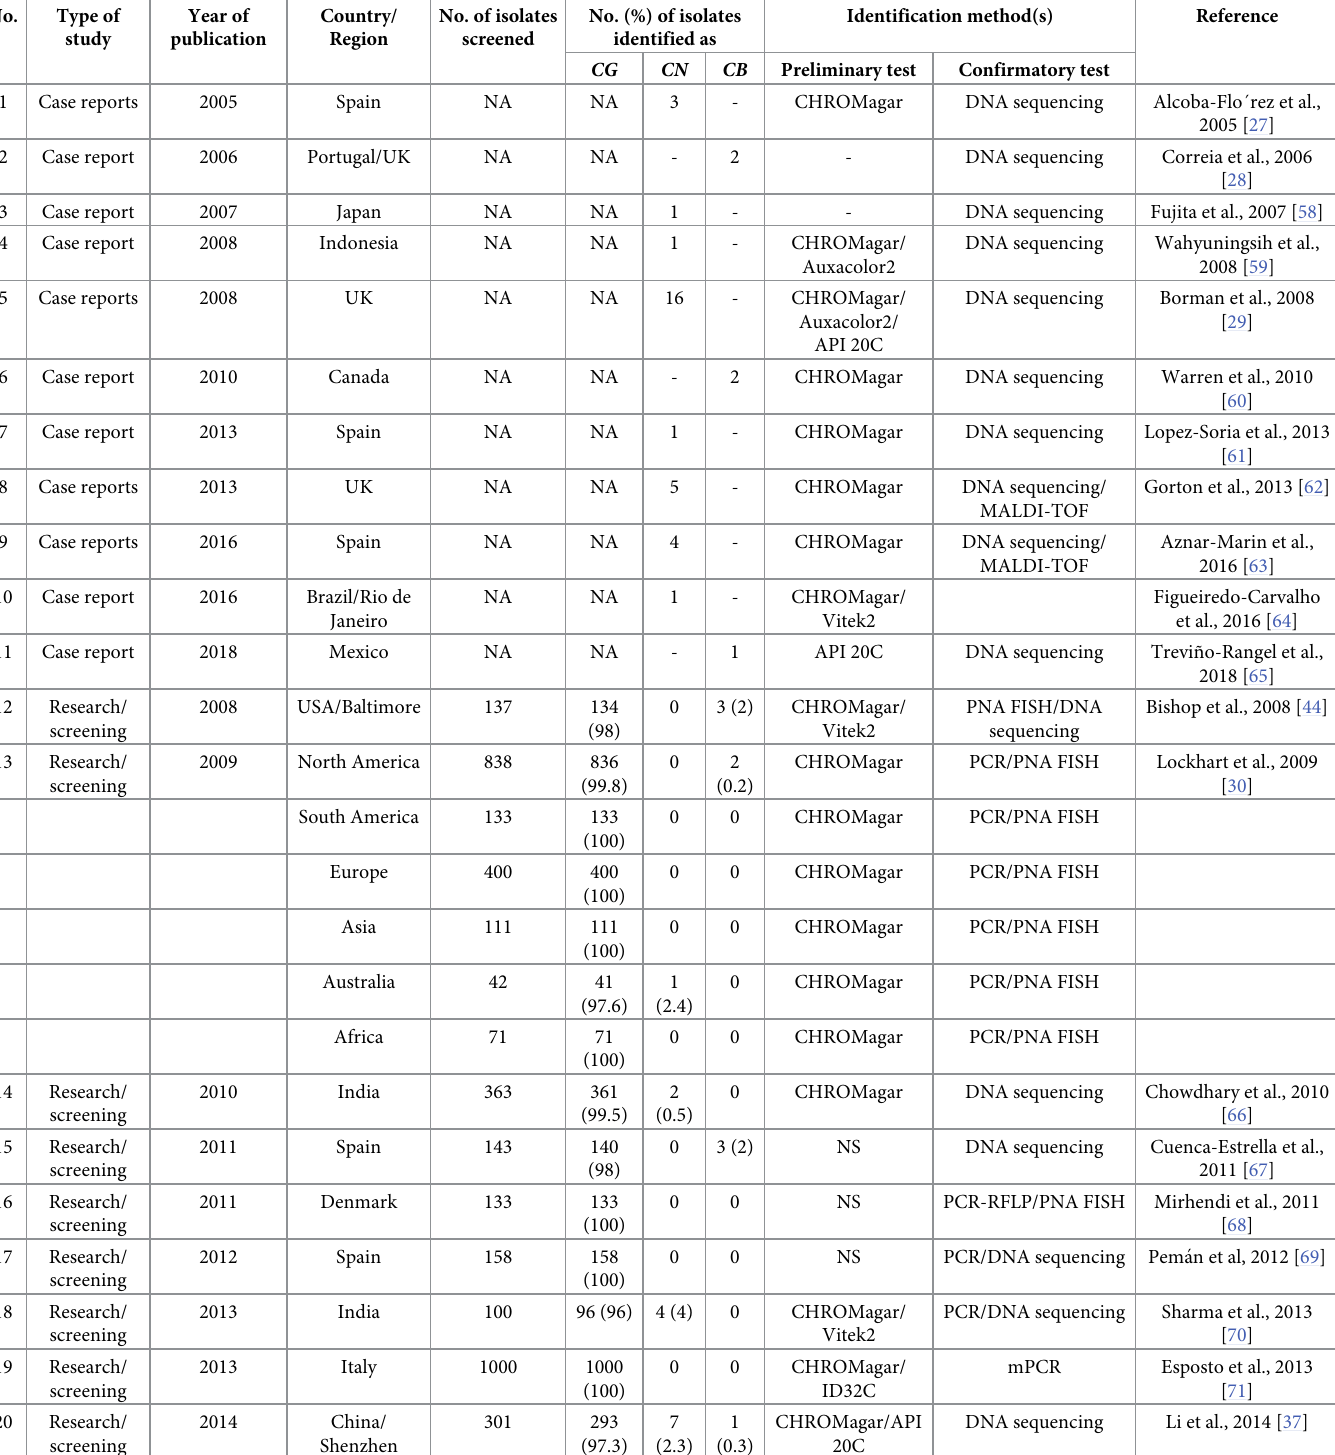
Table 1. Summary of published studies/case reports and screening methods used for the identification of C . nivariensis and C . bracarensis among C . glabrata sensu lato isolates.